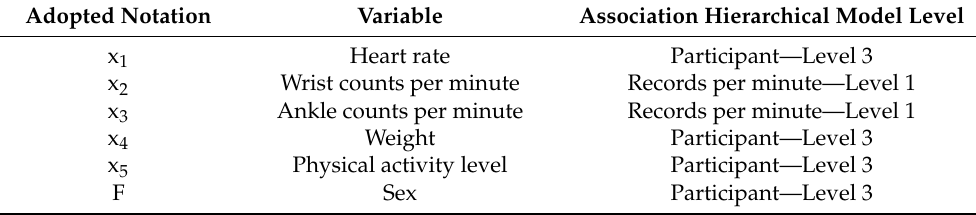
Table A1. Significant variables of the model according to their associated hierarchical